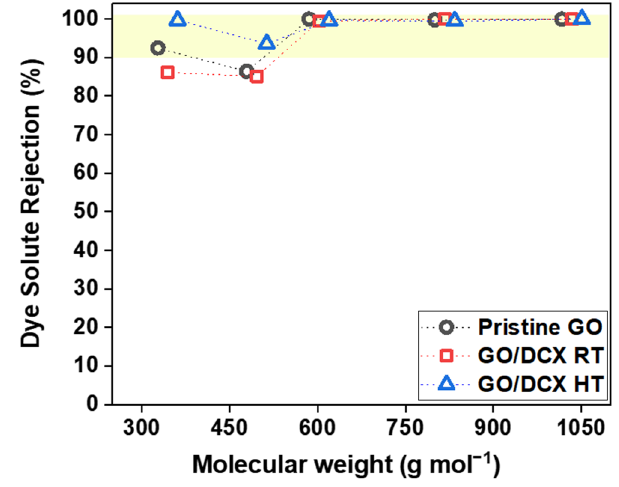
Figure 8. Molecular rejection efficiencies of the prepared GO membranes. All of the rejection tests were conducted with 10 mg L − 1 concentrations of different types of organic dye molecules with molecular weights ranging from 327 g mol − 1 to 1017 g mol − 1 at an applied pressure of 1 bar for 12 h. The molecular weights of the chosen organic dye molecules are as follows: RB, 1017 g mol − 1 ; MB, 800 g mol − 1 ; AF, 585.5 g mol − 1 ; RhB, 479 g mol − 1 ; MO, 327 g mol − 1 .